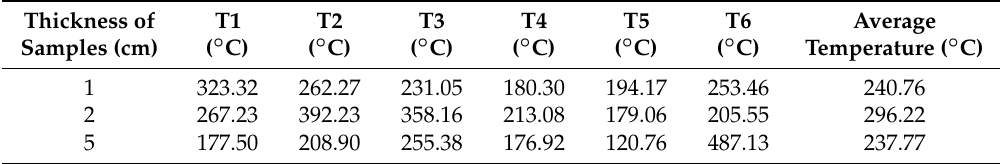
Table 2. Jump of the temperature for each